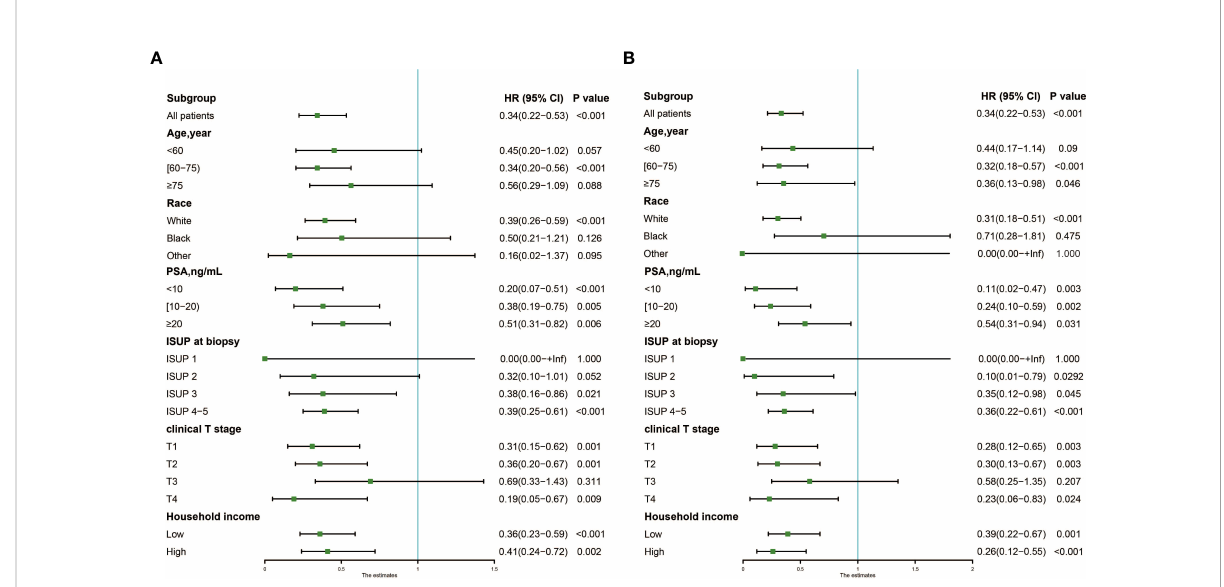
FIGURE 3 Forest plot showing results of Cox regression model for evaluating the prognostic role of local therapy in each subgroup. (A) OS; (B) CSS. OS, overall survival; CSS, cancer-speci fi c